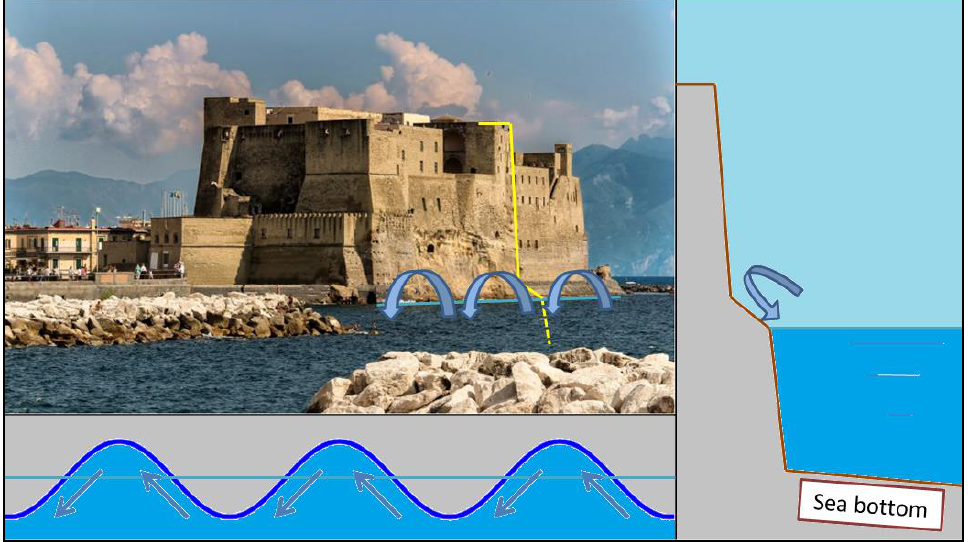
Figure 19. Hydrodynamic motion occurring on the western side of the Castel dell’Ovo. Water masses climb up the western bastion of Castel dell’Ovo and then are reflected back towards the seaside. This means that almost no energy dissipation occurs.